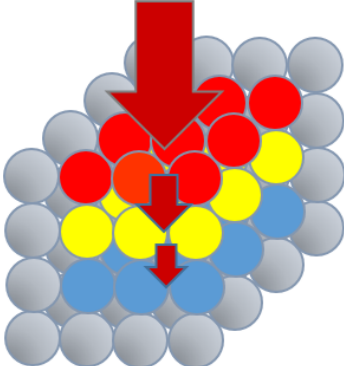
Figure 4. Schematic representation of the effect of a single laser pulse on a metal surface colored by red, yellow and blue, respectively, representing higher temperatures in the upper layers and lower temperatures in subsequent layers.